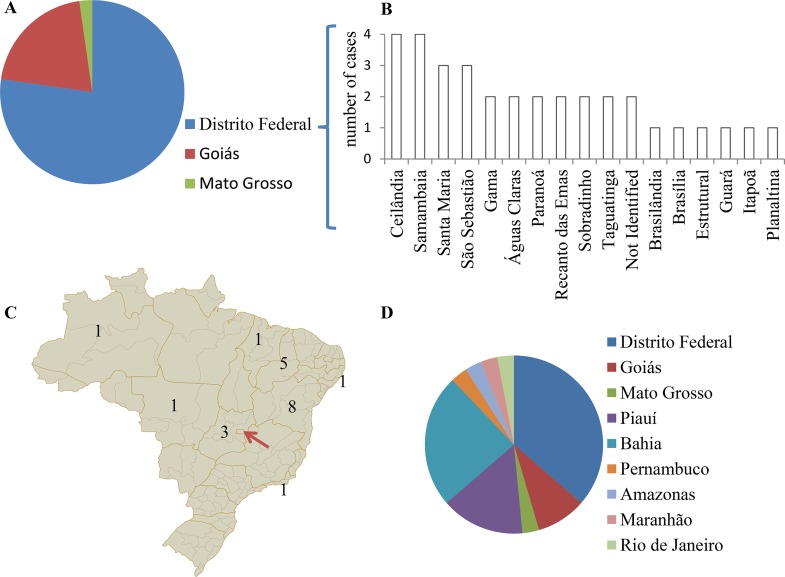
Residency history of leprosy cases identified in the temporary clinic.The 44 leprosy cases identified during the surveillance period, reported their residency based on state. Red arrow: Federal district. (A)—At the time of survey, 34 were resident in the Federal District, 9 in neighboring Goiás and 1 was living in Mato Grosso. (B)—For patients residing in the Federal District, further delineation was made to their current administrative region. (C and D)—Each case identified their state of origin.